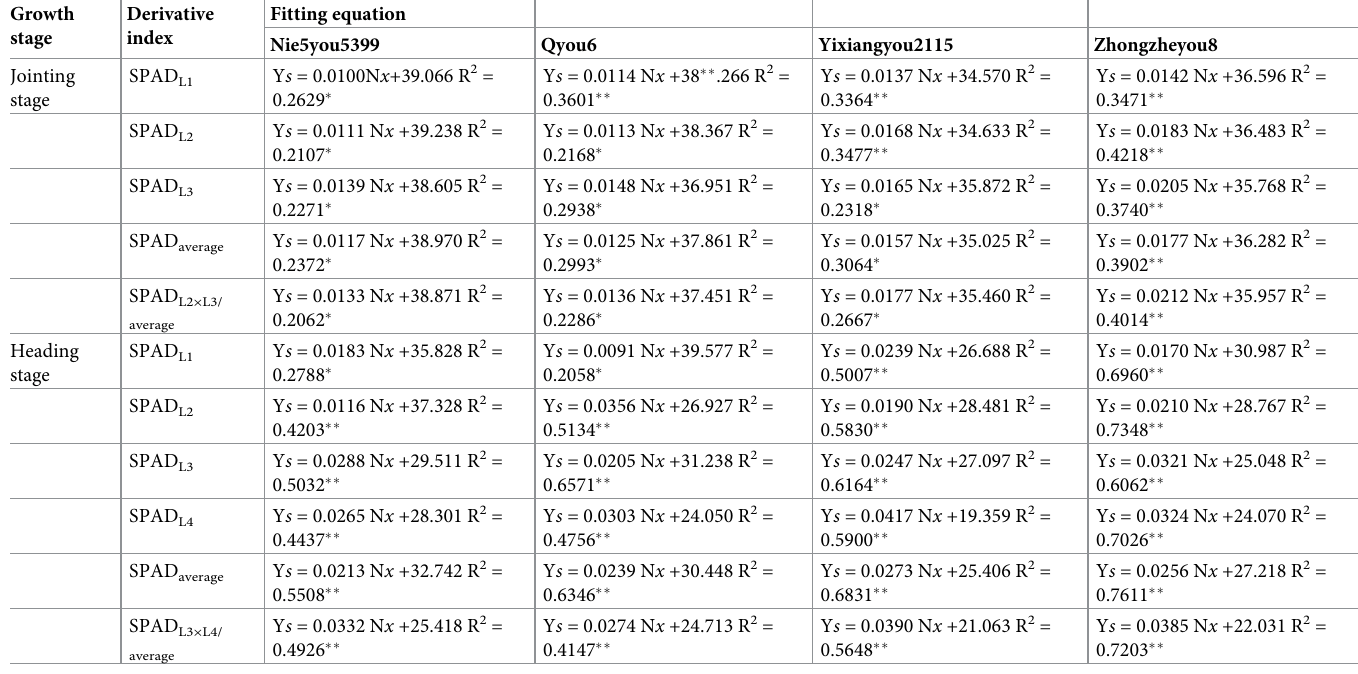
Table 2. Linear fitting relationship between the apparent N supply (N x ) and SPAD value derivative index (Y s ) at the jointing and heading in